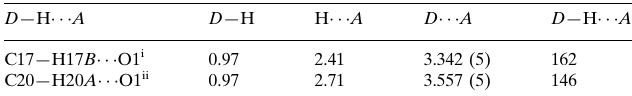
Hydrogen-bond geometry (A˚ , (cid:1)